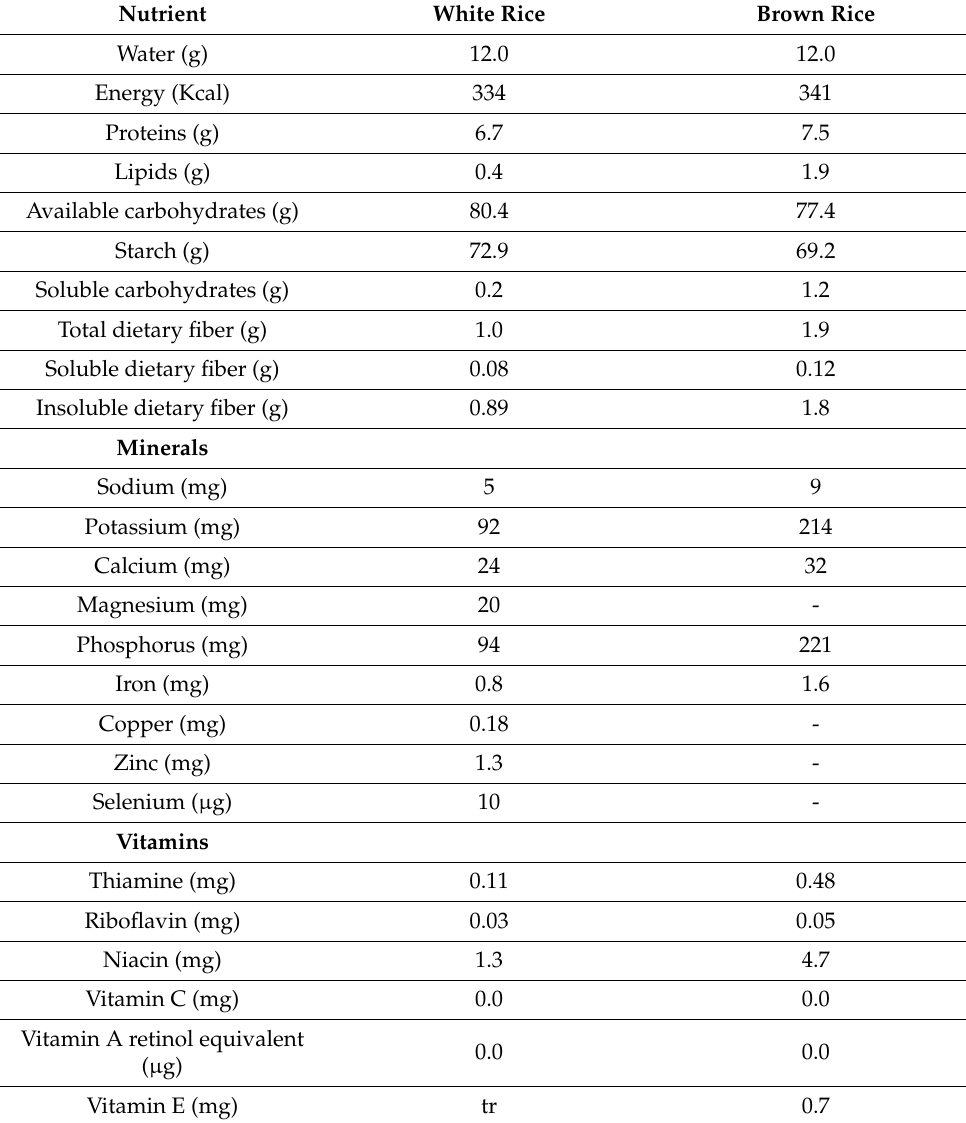
Table 1. Comparison of the nutritional components of white and brown rice (%)